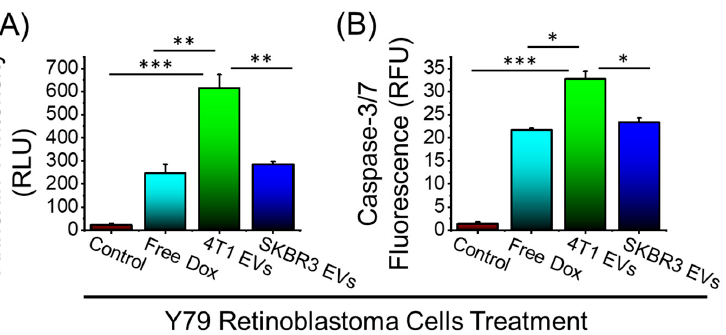
Figure 4. Anticancer efficacy of free Dox and Dox-loaded EVs in Y-79 human retinoblastoma cells. ( A ) Annexin V staining for detecting cell apoptosis after 24h treatment. ( B ) CellEvent TM